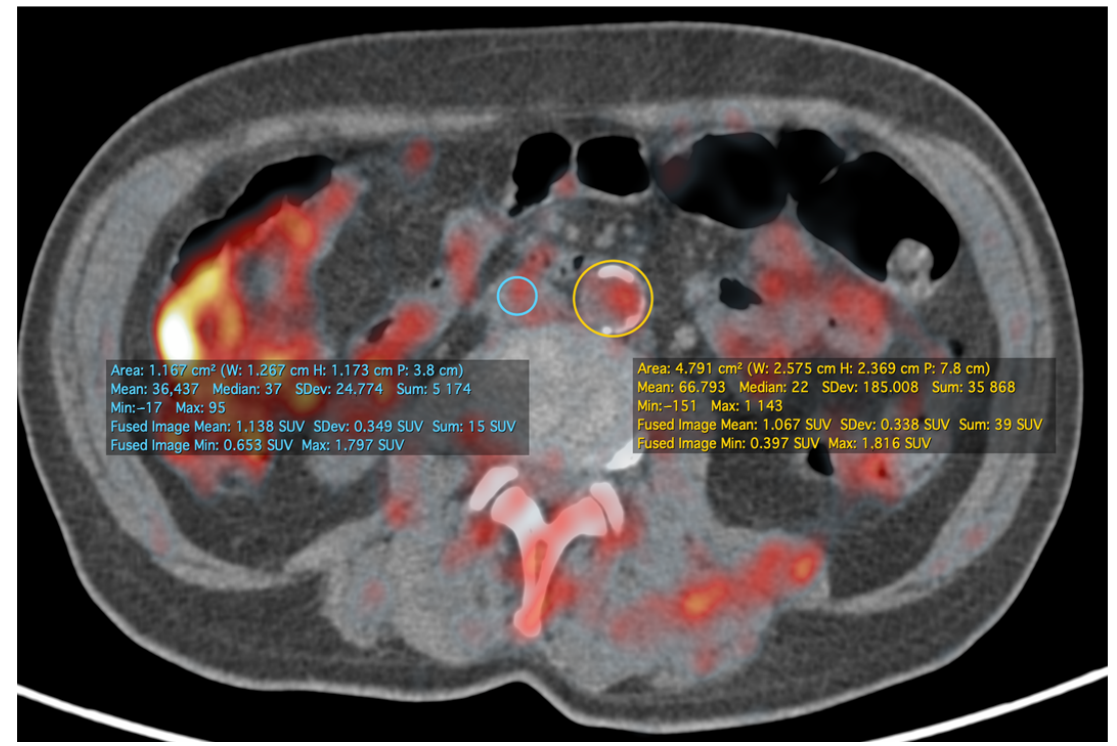
Figure 2. The same patient and study as in Figure 1. At the infrarenal level of the aorta, more prominent calcific atherosclerotic plaques are visible. The image shows a method of calculating TBR as a ratio of SUV in the aorta region of interest and SUV in the venous blood pool on the same level—in this case, the inferior vena cava was used. TBRmax at this level was about 1.01. All calculations were performed in OsiriX MD (Pixmeo SARL, Bernex, Switzerland).